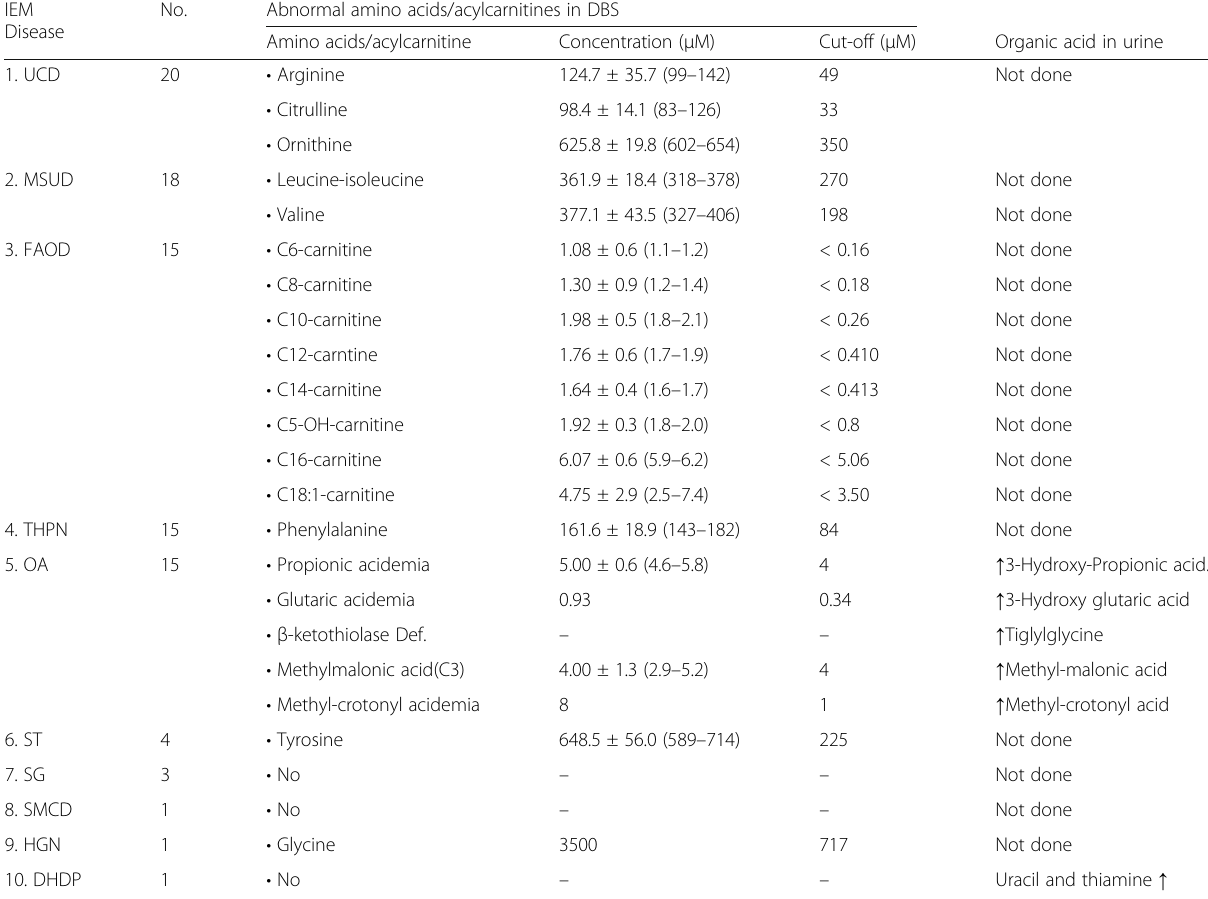
Table 8 The abnormal amino acids/acylcarnitines in dried blood spots and organic acids in urine of the different disease types in the studied cases IEM